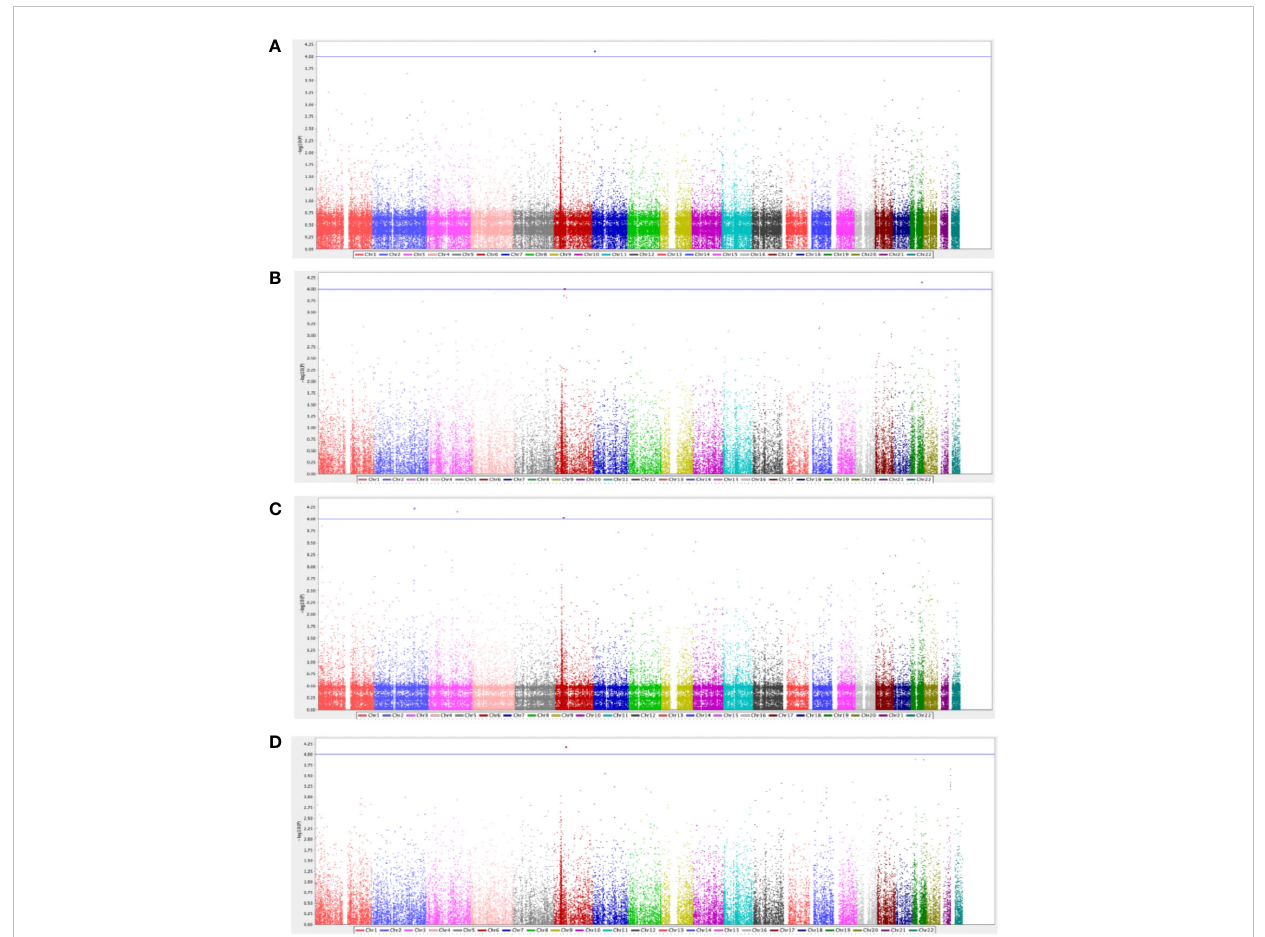
FIGURE 1 Manhattan plot for diabetes-related (A) retinopathy complications (n=62), (B) neuropathy complications (n=47), (C) nephropathy complications (n=22), and (D) cardiovascular complications (n=42). The GWAS analyses results are shown on the y-axis as -log10(p-value) and on the x-axis is the chromosomal location, adjusted for age, gender, and BMI. The blue horizontal line illustrates the suggestive genome-wide association threshold (p<5×10 -4